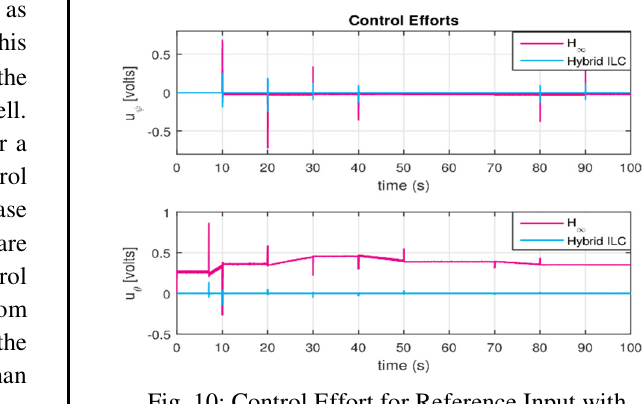
Fig. 10: Control Effort for Reference Input with Sharp